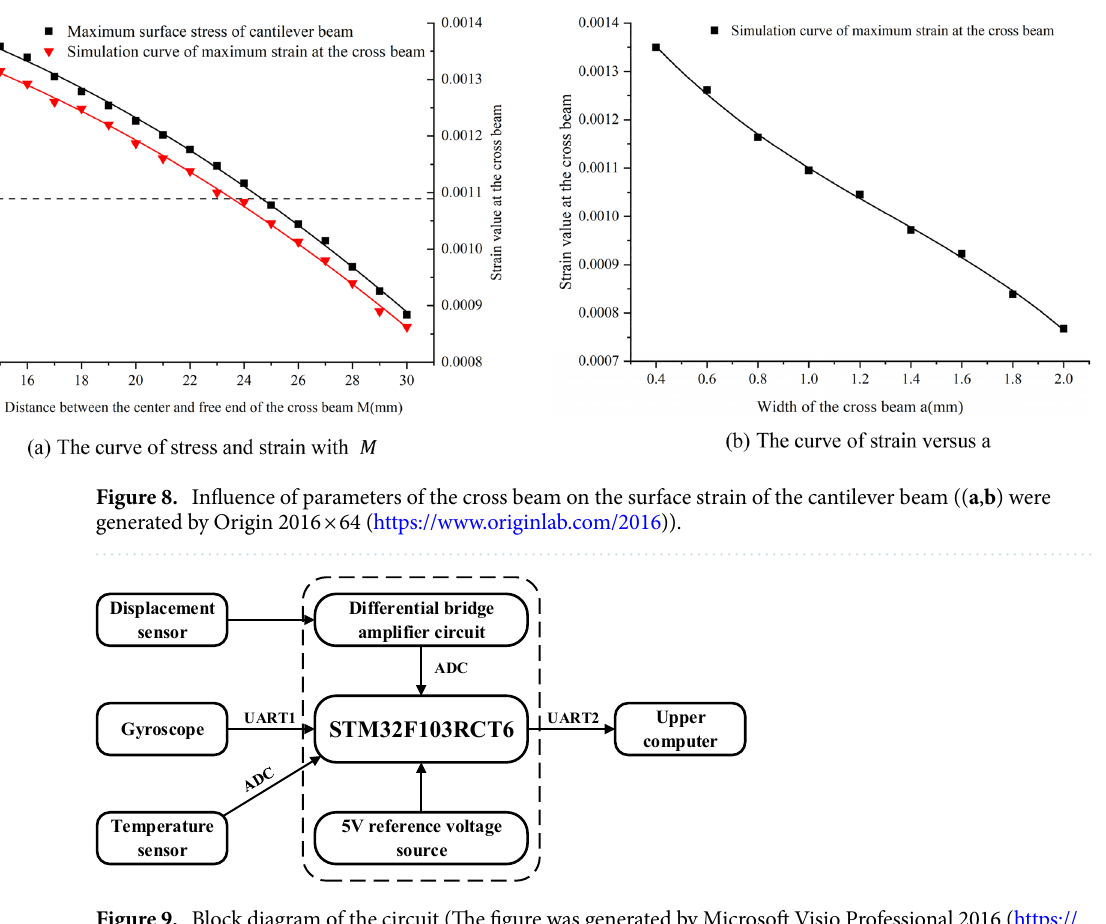
Figure 9. Block diagram of the circuit (The figure was generated by Microsoft Visio Professional 2016 (https:// www. micro soft. com/ zh- CN/ downl oad/ detai ls. aspx? id=